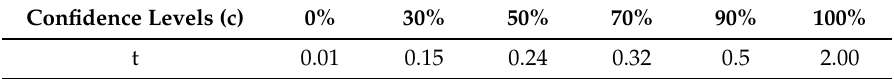
Table 1. Fitting data of parameter t in the bound model of the confidence